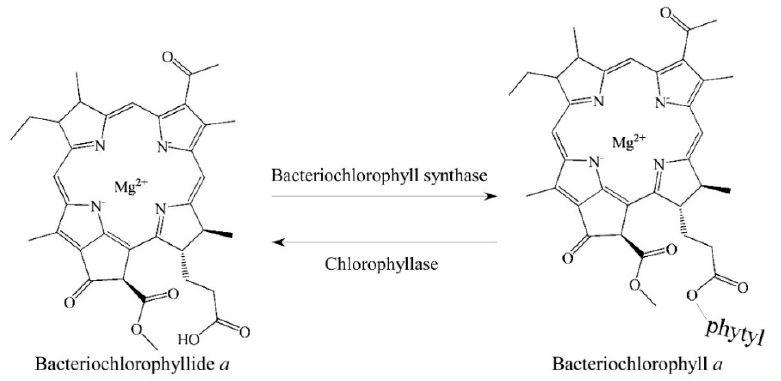
Figure 2. The relation between bacteriochlorophyllide a and bacteriochlorophyll a .